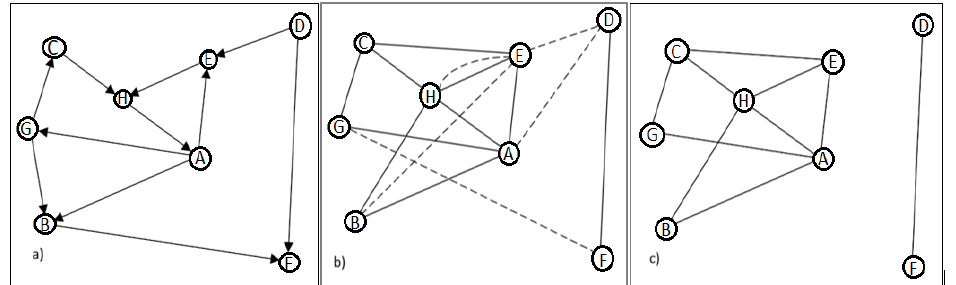
Figure 1. Examples of networks. a) Simplex directed network with eight nodes. b) Multiplex bidirectional network with one component. The distinct types of lines represent the different layers. c) This network represents the resultant network when the dot-line layer in figure b fails or disappears. After the failure, we get a simplex bidirectional network with two